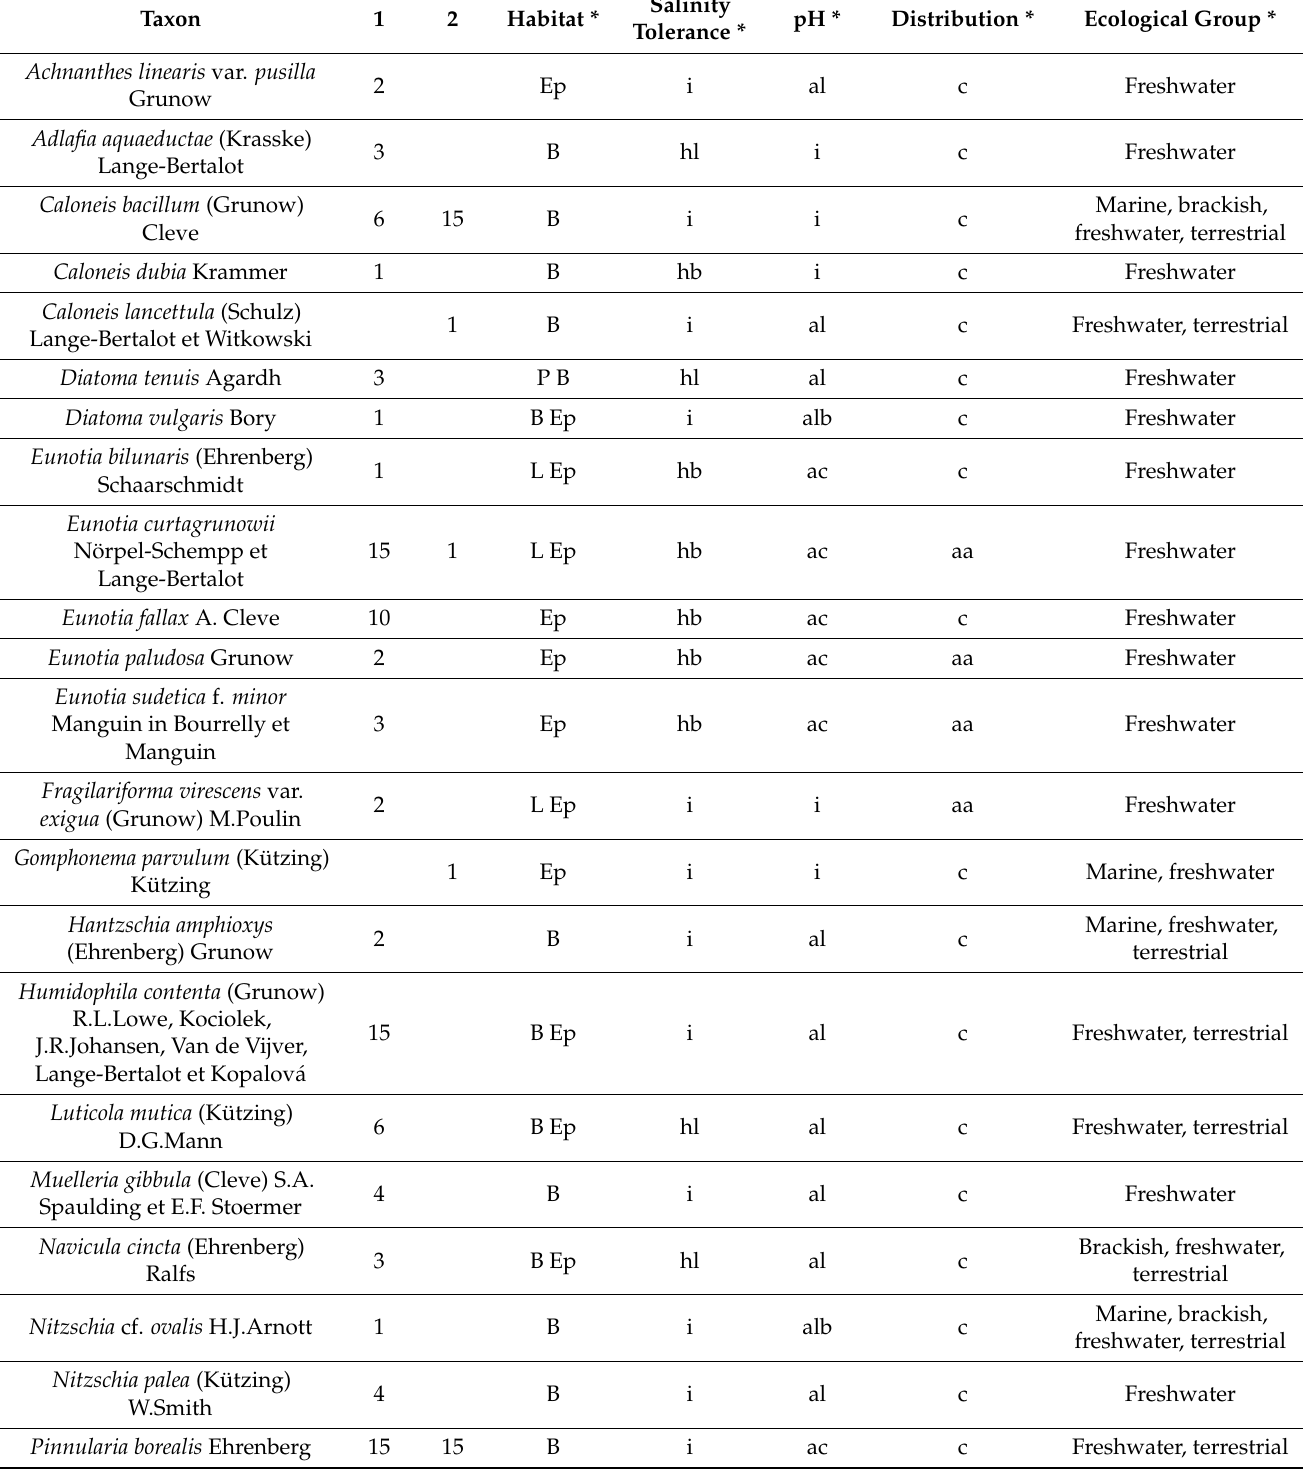
Table A1. List of diatom taxa with the relative abundance and ecological preferences * [71–79] in the volcanic soils of Mutnovsky and Gorely